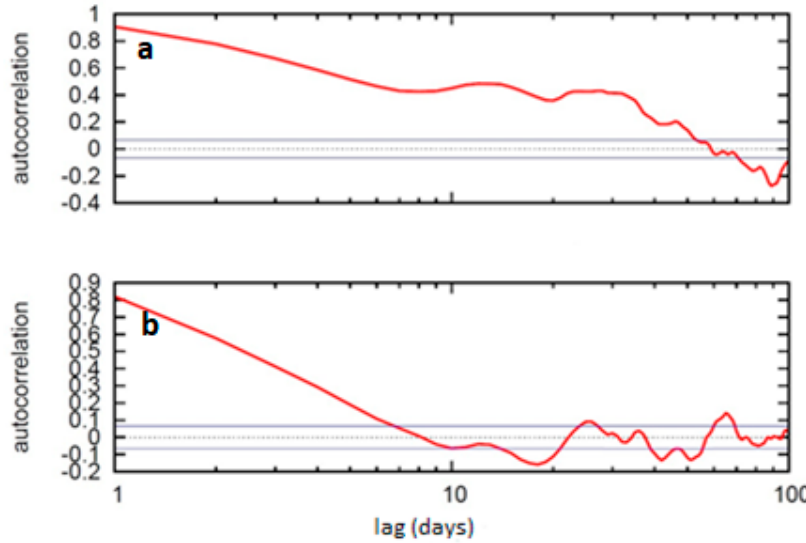
Figure 5. The autocorrelation of the IE diagnostic (ordinate), where the lag is presented in days (abscissa) for ( a ) the representative concentration pathway (RCP) 4.5 IPSL-CM4 (top), and ( b ) the RCP 4.5 IPSL-CM5 (bottom).